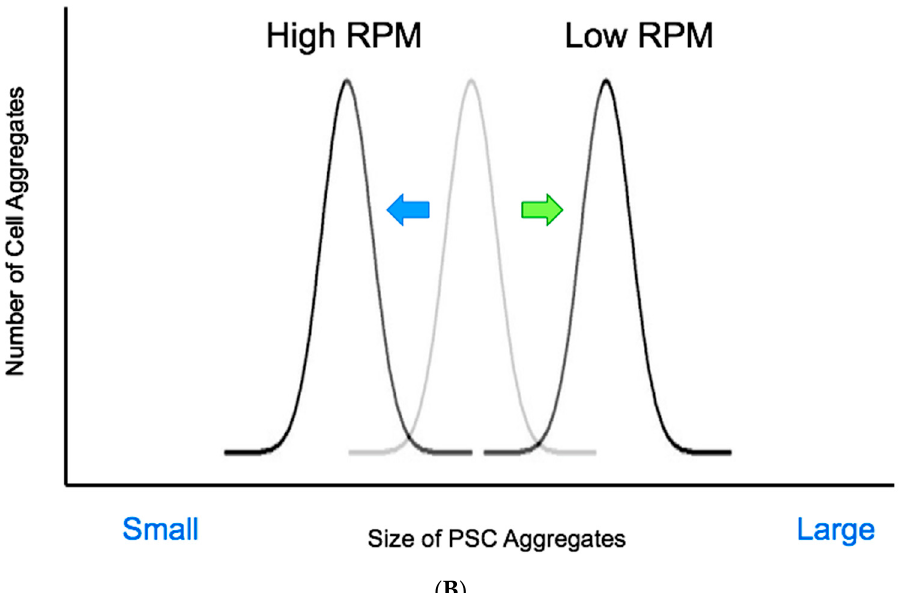
Figure 2. ( A ) Projected distribution of cell aggregate sizes in Vertical-Wheel bioreactor (homogeneous) vs. horizontally stirred bioreactor (non-homogeneous) hydrodynamic environments. ( B ) inverse correlation between average pluripotent stem cells (PSC) aggregate diameter and agitation rate in Vertical-Wheel bioreactors.